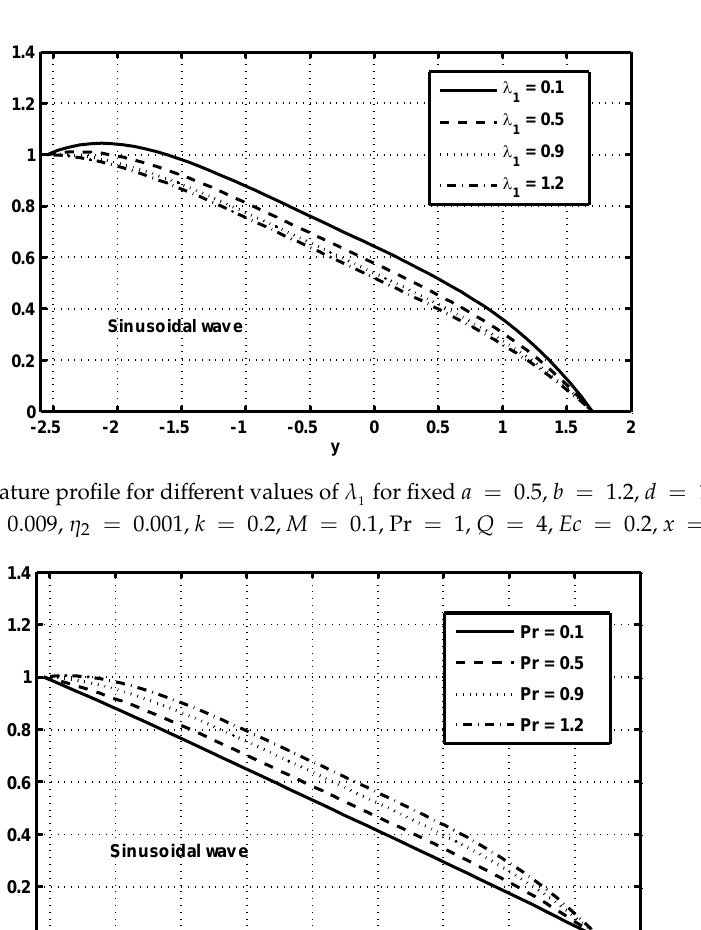
Figure 12. Temperature profile for different values of Pr for fixed a = 0.5, b = 1.2, d = 1.5, ϕ = 0.009, η = 0.001, λ = 1, k = 0.2, M = 0.1, Q = 4, Ec = 0.2, x = 1.